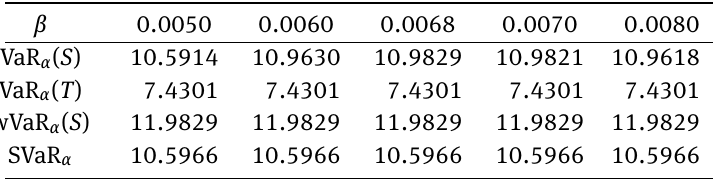
Table 1: Summarized results for Example